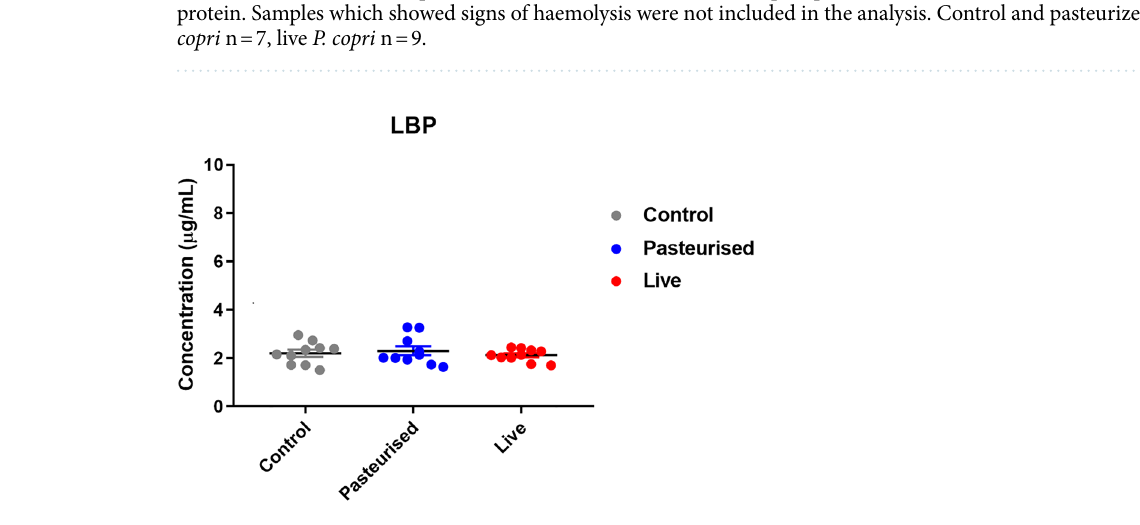
Figure 6. LBP levels in plasma after 29 days of P. copri gavage (n =